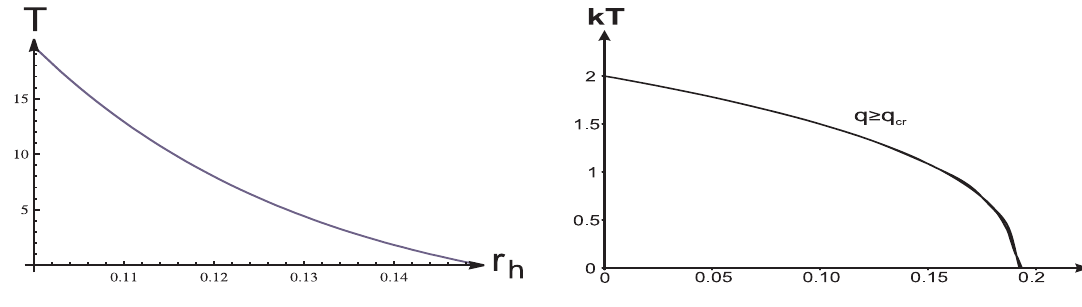
Figure 6. Typical behavior of temperature on the internal ( left ) and cosmological ( right )